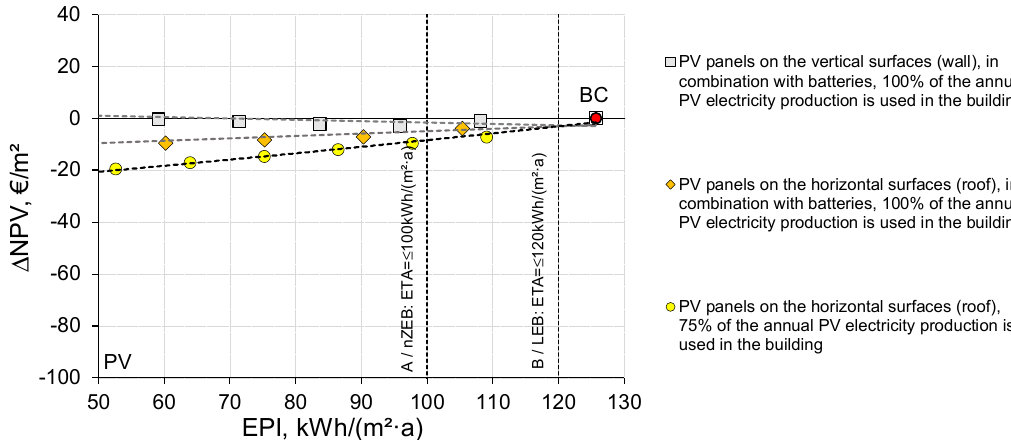
Figure 4. Change in the net present value ( Δ NPV) in the case of different PV solutions.